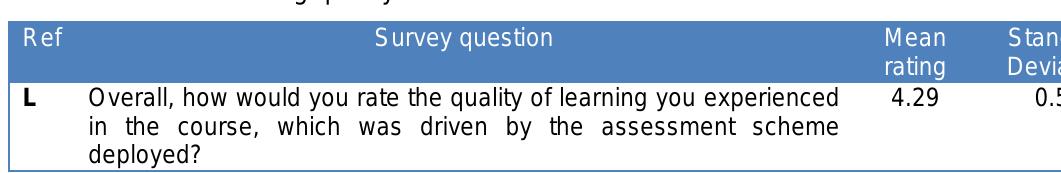
Table 4: Overall learning quality Ref Survey question Mean